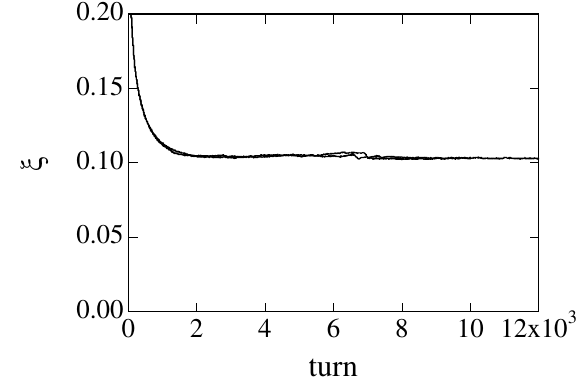
FIG. 9. Evolution of luminosity for head-on collision without crossing angle and crab collision with a finite crossing angle, 11